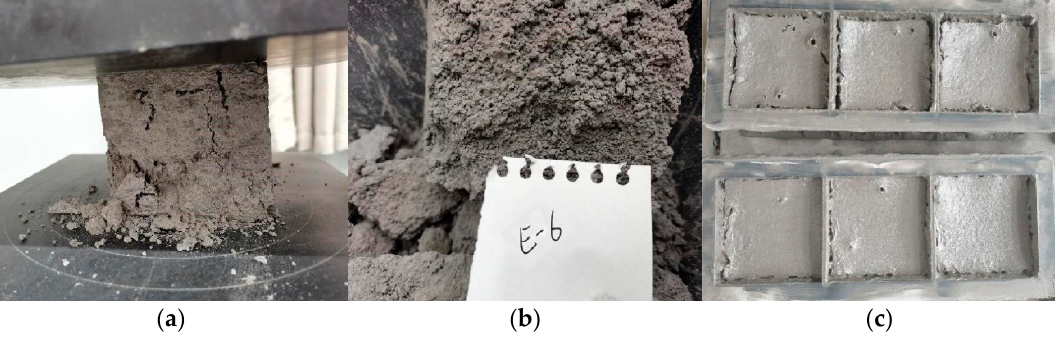
Figure 3. Effects of various factors on the compressive strength of foam concrete.